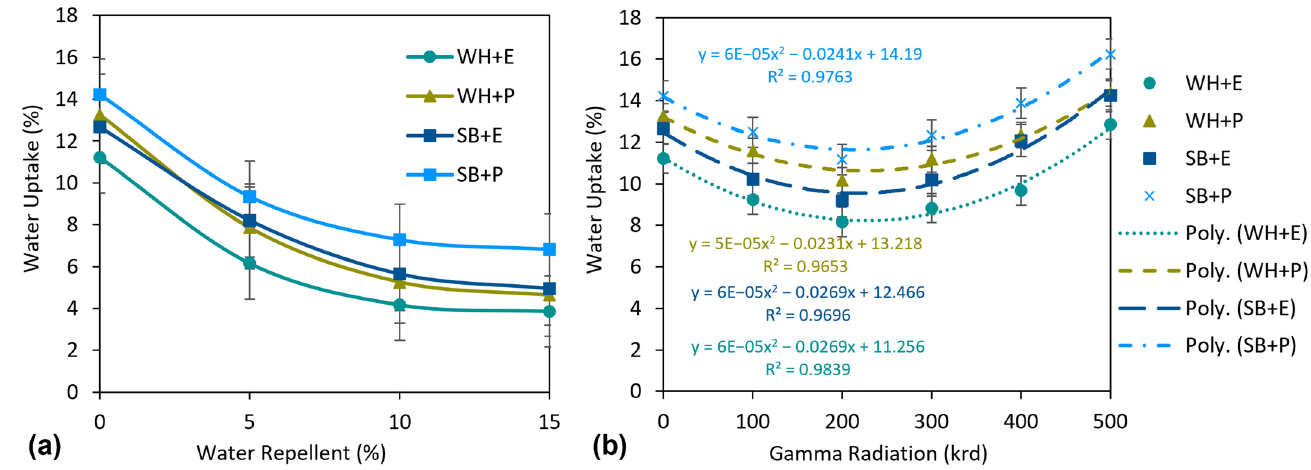
Figure 7. ( a ) Effect of water-repellent treatment and ( b ) effect of gamma radiation on the water uptake (%) of the composites.